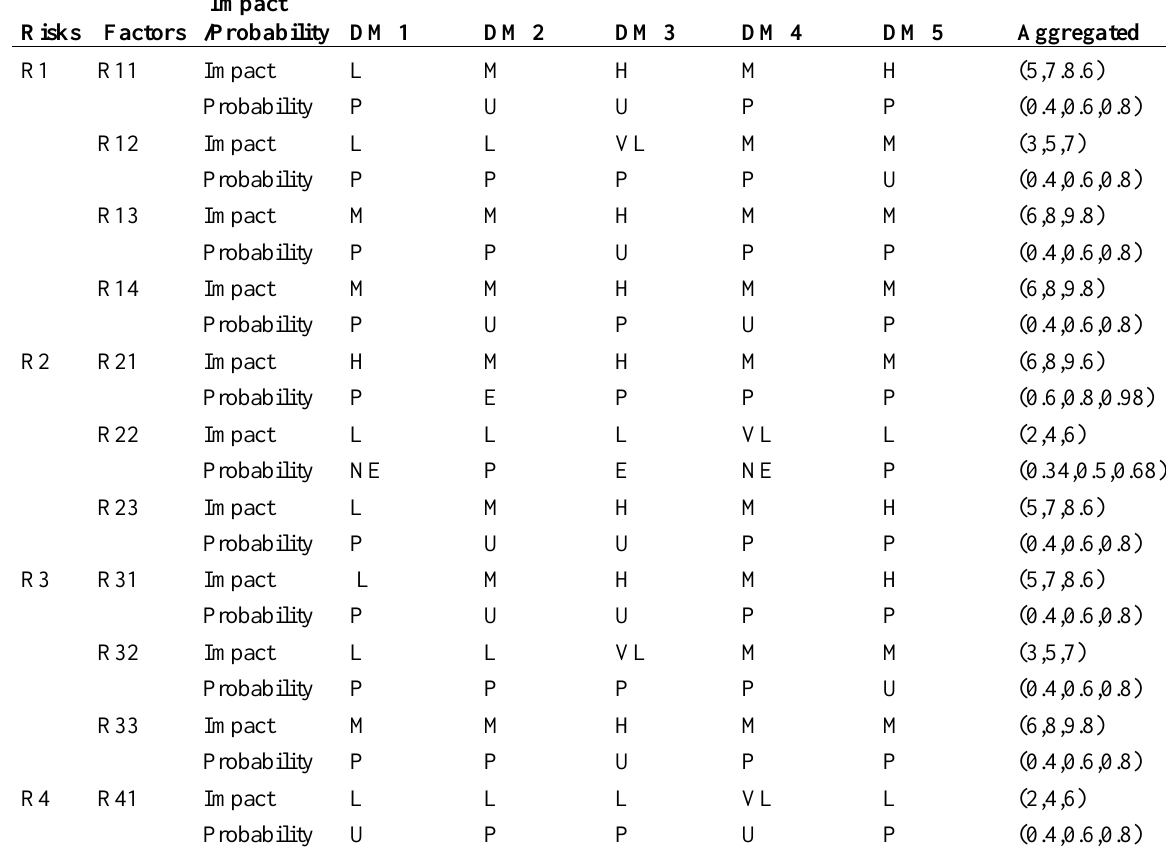
Table 5. The estimation values for impacts and associated probabilities. Risks